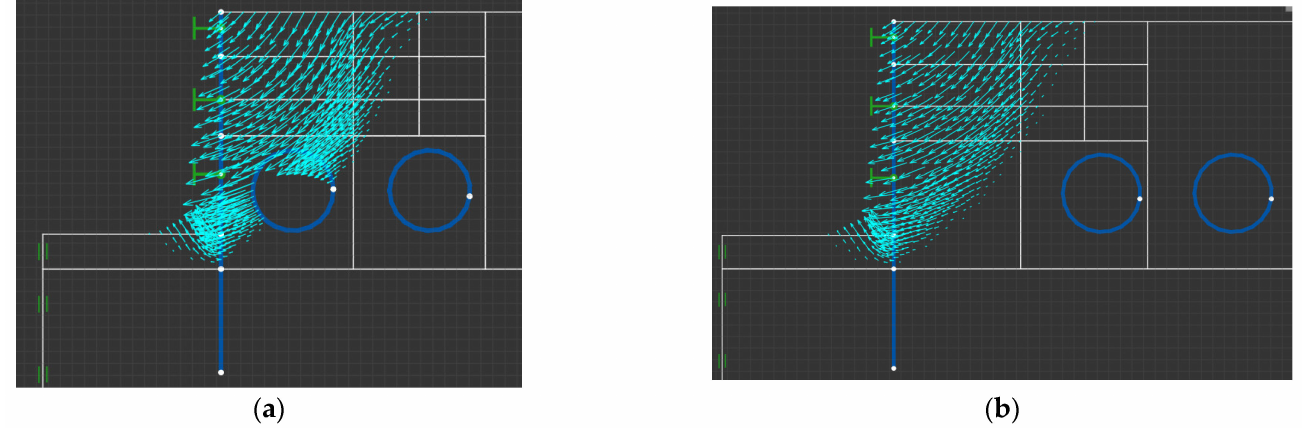
Figure 16. Incremental displacement vector under different horizontal distance L in stage (4): ( a ) L = 0.33 H and ( b ) L = 1.0